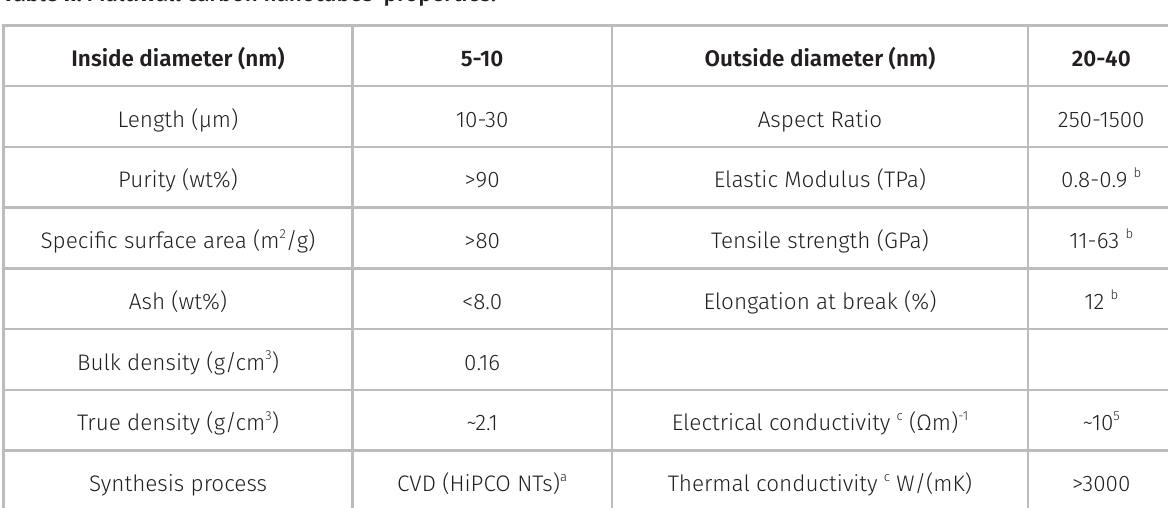
Table II. Multiwall carbon nanotubes’